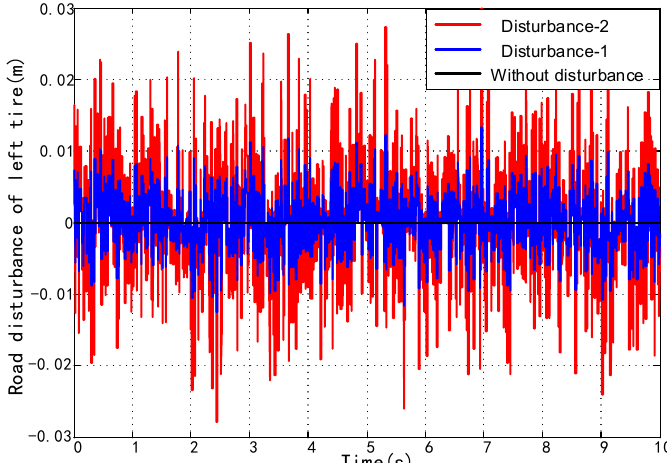
Figure 15. The road disturbance imposed on the system.